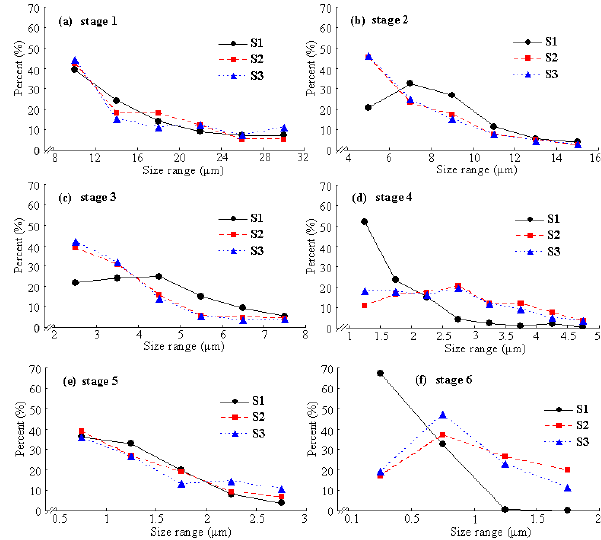
Fig. 4. Size range of analyzed particles on stages 1-6 for samples S1-S3.